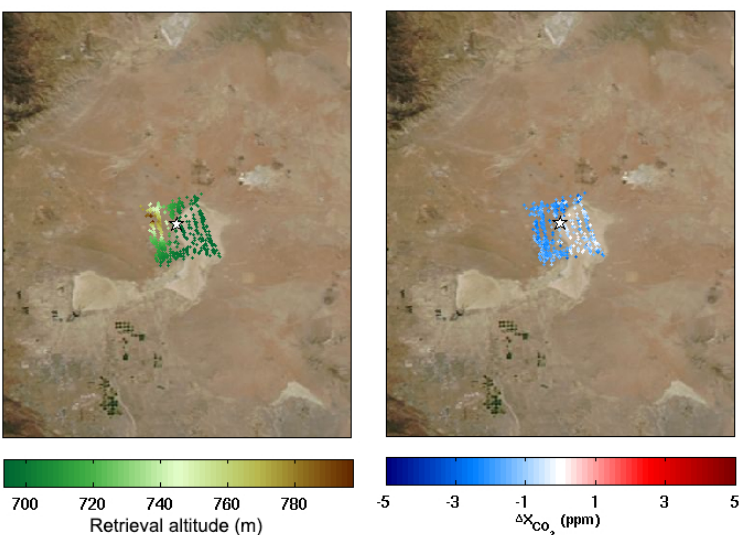
Figure 7. Edwards target on 19 April 2015. The background is the MODIS true-color image of the Edwards area at the time of the target-mode maneuvers. The white star indicates the location of the Edwards TCCON station. The left panel shows the elevation model of the surface, and the right panel shows the difference in OCO-2 X CO from the value recorded by the TCCON instrument. A spatial bias related to the surface 2 brightness is clearly present in this target-mode measurement. In other Edwards target-mode measurements, this surface brightness-correlated bias is not as